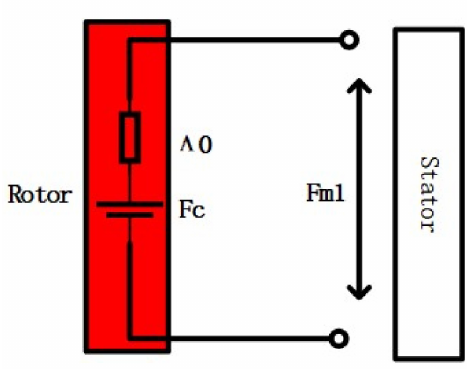
Figure 7. Equivalent magnetic